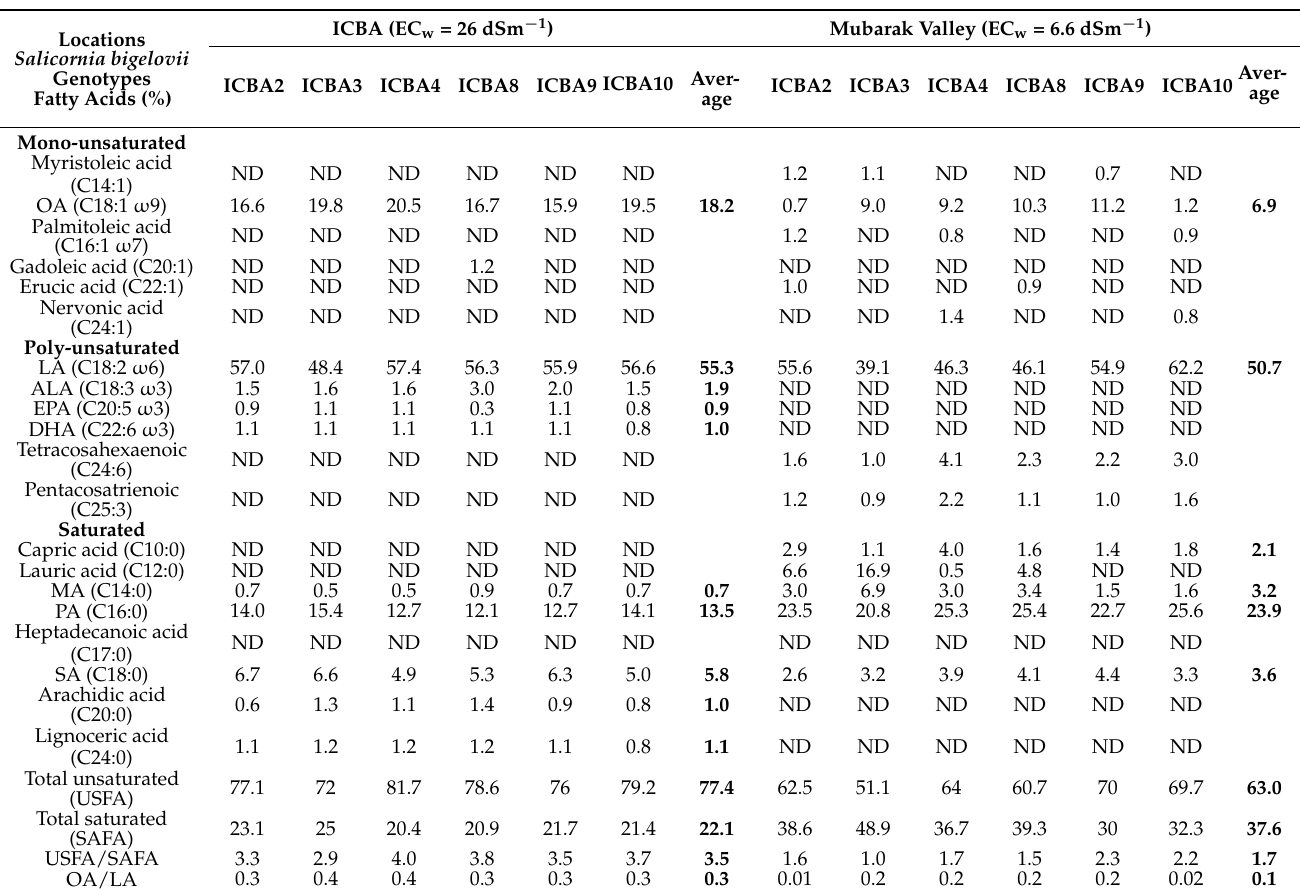
Table A5. Fatty acids composition (%) analyzed for seeds of six Salicornia bigelovii genotypes at ICBA’s experimental station and at Mubarak Valley in Egypt. The average value per parameter from all genotypes was calculated (in bold) for each